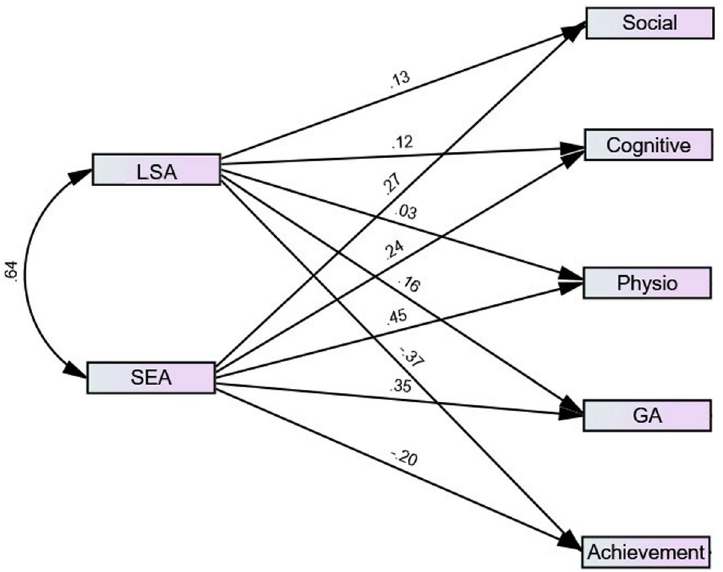
Fig 2. The associations between science anxiety subscales and test anxiety subscales, general anxiety, and science achievement. LSA = learning science anxiety; SEA = science evaluation anxiety; social = social derogation; cognitive = cognitive obstruction; Physio = physiological tenseness; GA = general anxiety; Achievement = Science